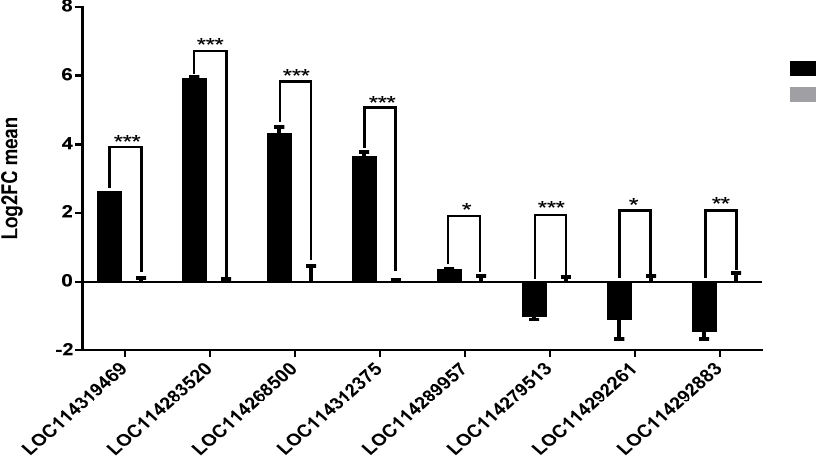
Figure 9. qRT-PCR verification of DEGs. Notes: 1. TreT3(black bar) represents the treatment group and ConT3 (gray bar) represents the control group which DEGs was set to 0. Positive value of the vertical axis represents DEGs up-regulation and negative one represents DEGs down-regulation. 2. * means p < 0.05 is statistically different, ** means p < 0.01 is considered to have significant statistical difference, and *** means p < 0.001 is considered to have extremely significant statistical difference. Means p refers to the p -value obtained by the significance T-test